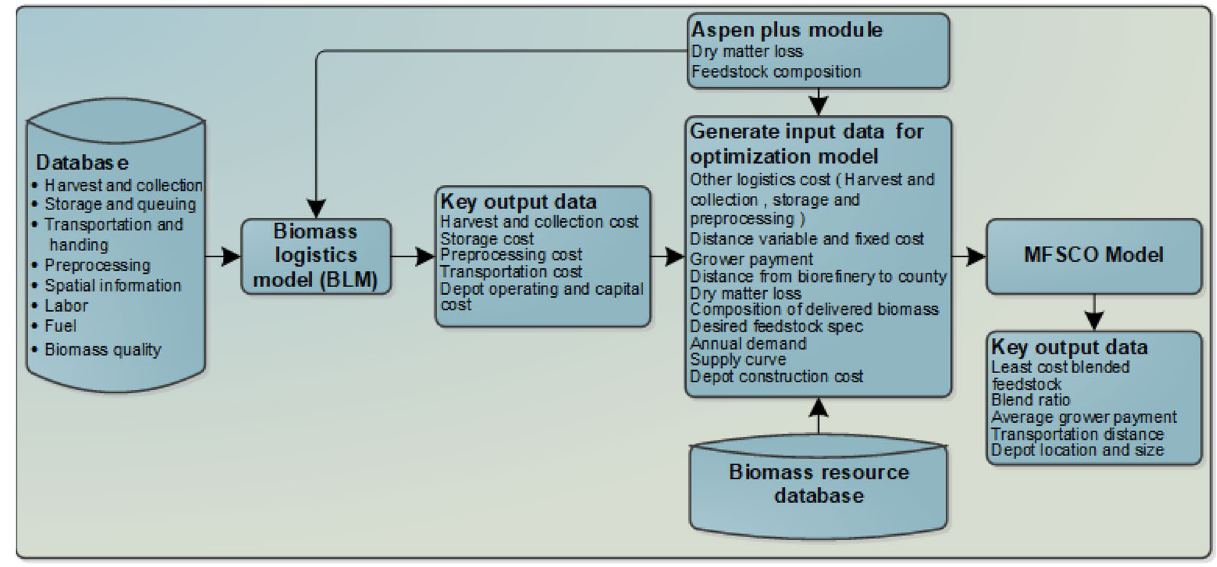
Figure 2. Data flow among models. Biomass logistics model and MFSCO model are utilized in this